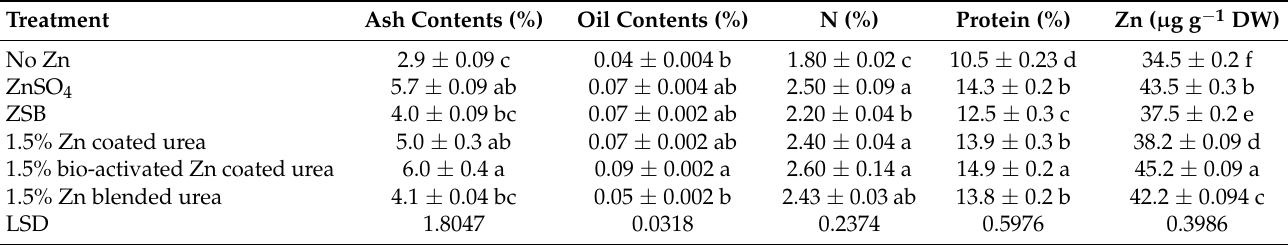
Table 1. Comparative effectiveness of the optimum level of zinc blended, zinc coated, and bioactivated zinc-coated urea to improve quality parameters under field conditions in wheat.